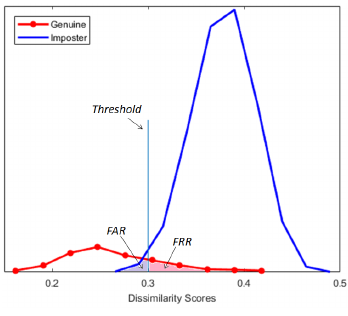
Figure 1. Probability distributions of genuine and impostor ! i ) ! g ) and P ( x scores P ( x | |